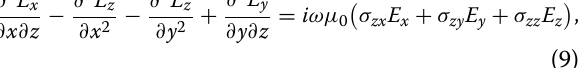
angular frequency. The staggered grid finite difference (SFD) scheme of Yee (1966) was used to discretize the electric fields, where the conductivity tensor is defined at related to the applied periodic boundary condition. The